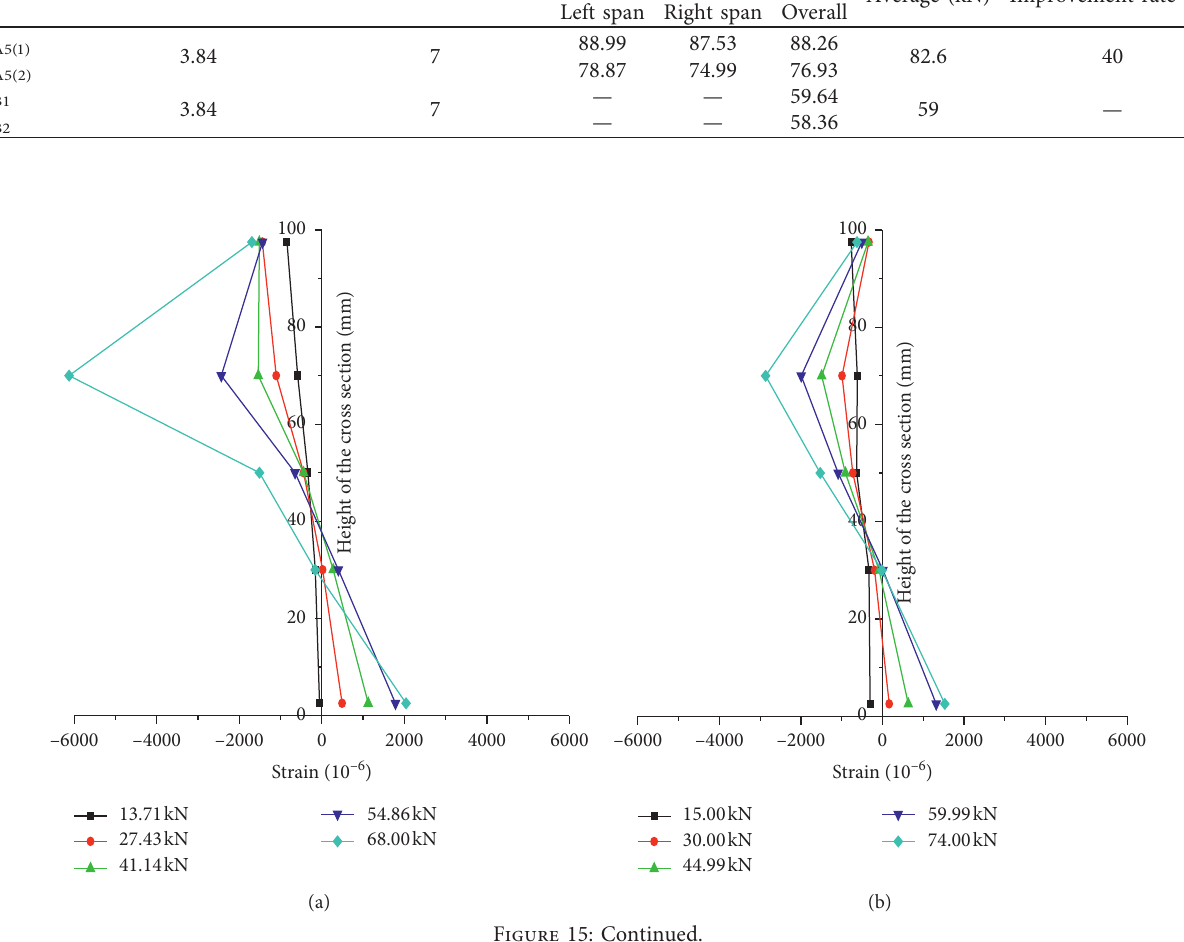
Figure 14: Load-deflection curves of simply supported beams and continuous beams under the same working condition. Table 7: Comparison of bearing capacities of hinged beams and continuous beams under the same working condition. Beam no. Reinforcement ratio (%) Prestressing force